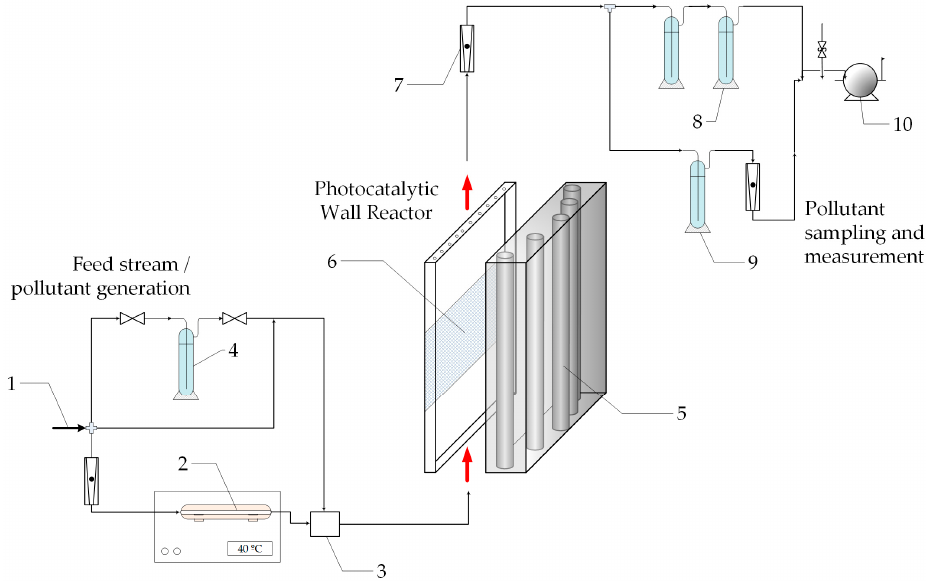
Figure 2. Experimental set-up: (1) Clean dry air; (2) thermostated formaldehyde (HCHO) generator;